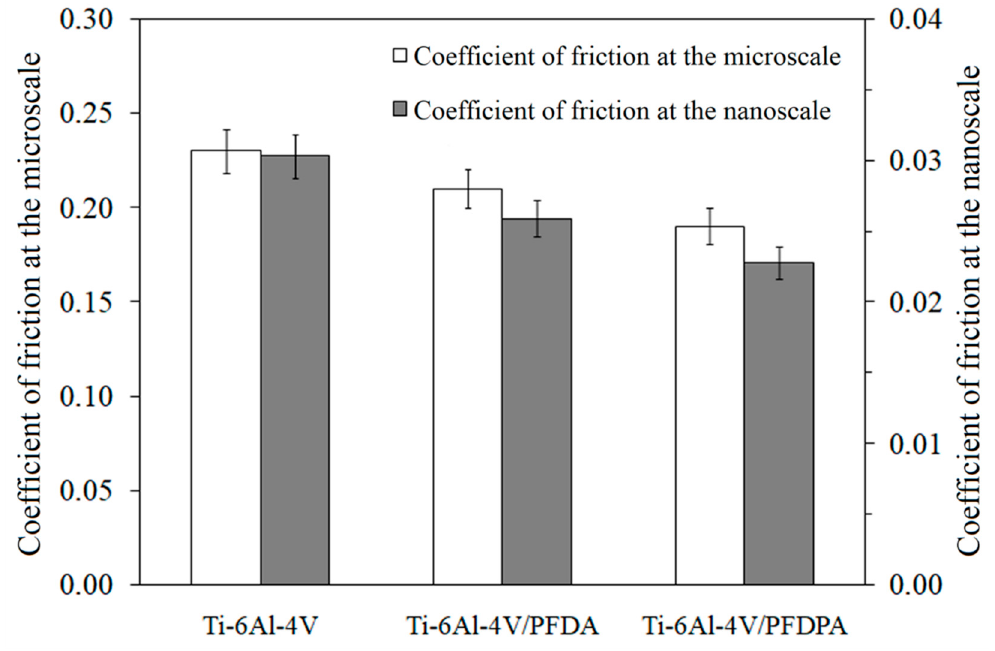
Figure 7. The coe ffi cient of friction values obtained in nano- and millinewton load ranges for a silicon nitride counterbody.